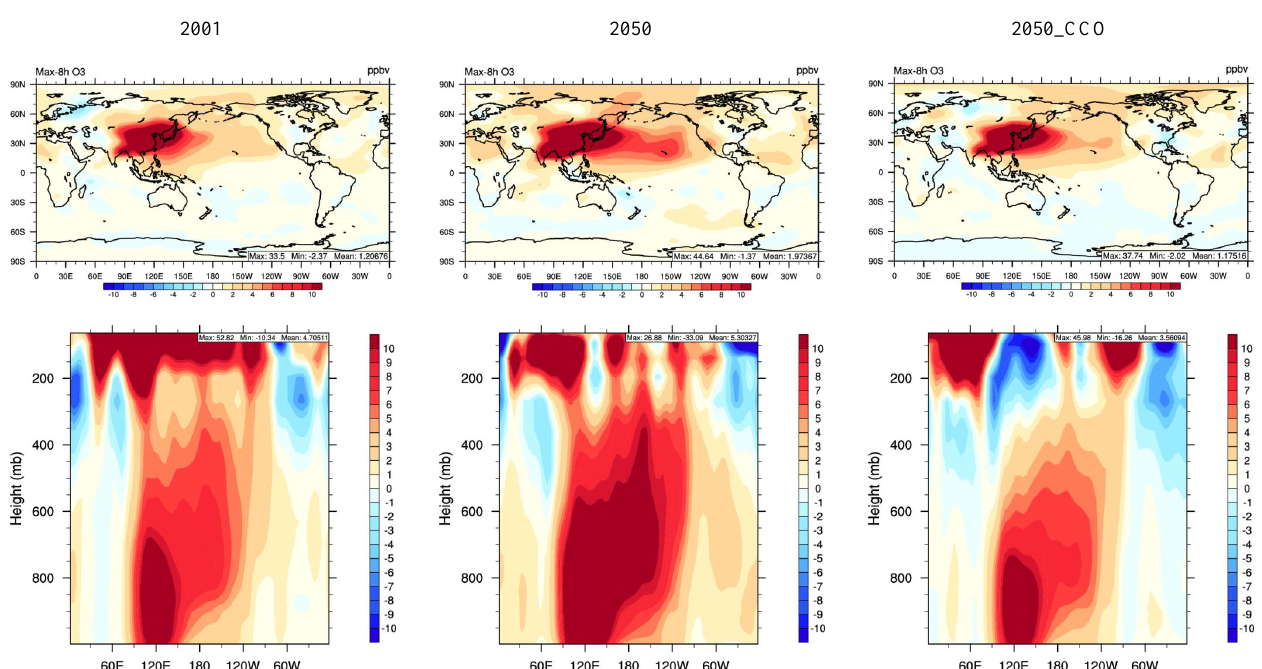
Figure 6. The difference in the spring (MAM) maximum 8-hr average surface ozone mixing ratio (top) and the mid-latitude (24°N to 60°N) meridional averaged vertical cross section of ozone (bottom) between the simulations with and without EAAEs for the current (2001) and future (2050 and 2050_CCO) scenarios.